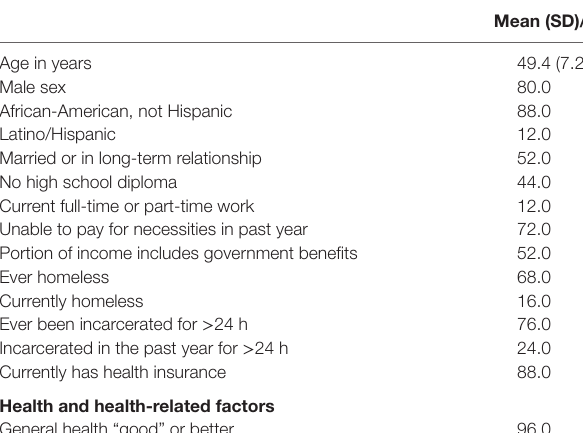
TaBle 1 | sociodemographic and background characteristics and health factors ( N =